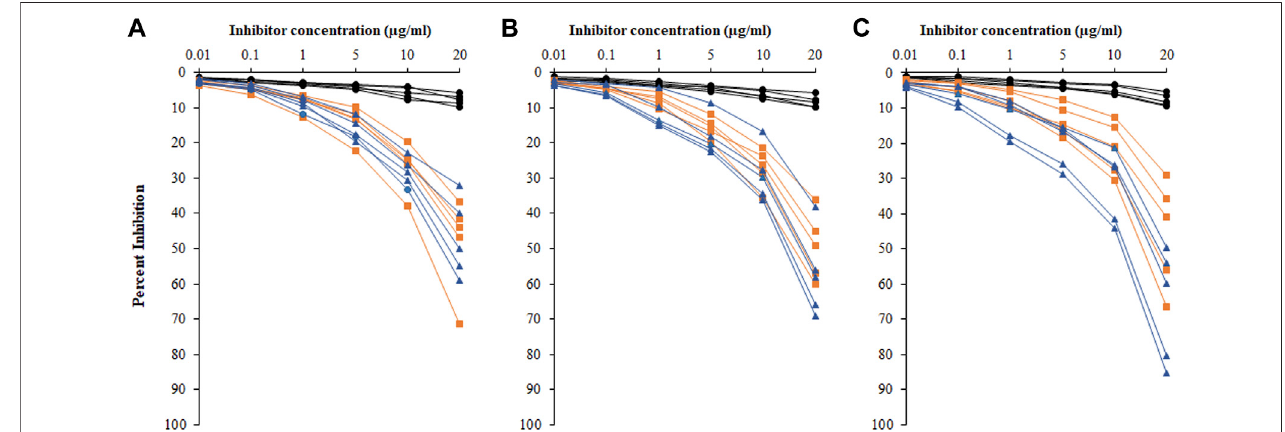
FIGURE 6 | Percentage inhibition of serum autoantibodies was detected using ROS-His-H1 as an inhibitor with varying concentrations (0.01 – 20 μ g/ml) for all samples from healthy control (- C -) HC, HL (- ■ -), and NHL (- ▲ -) subjects. Sample numbers 1 – 5 (A) ; from 6 to 10 (B) ; and from 11 to 15 (C) from all the cohorts. Serum samples of 1:100 dilutions were used in the assay. All samples were read on an ELISA reader at 410 nm. Each sample was run in triplicate.